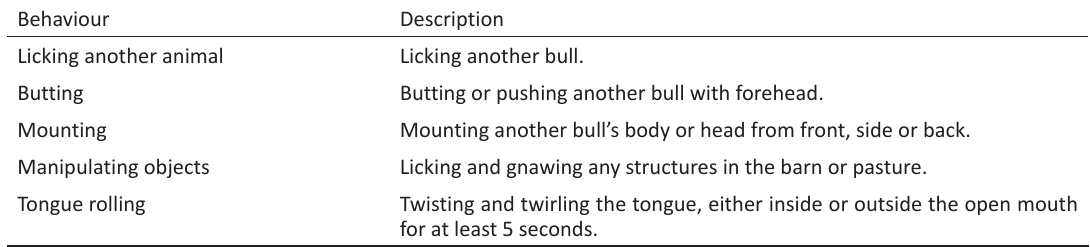
Table 2. Description of postures and activities recorded during one-zero sampling observations Behaviour Description Licking another animal Licking another bull. Butting Butting or pushing another bull with forehead. Mounting Mounting another bull’s body or head from front, side or back. Manipulating objects Licking and gnawing any structures in the barn or pasture. Tongue rolling Twisting and twirling the tongue, either inside or outside the open mouth for at least 5